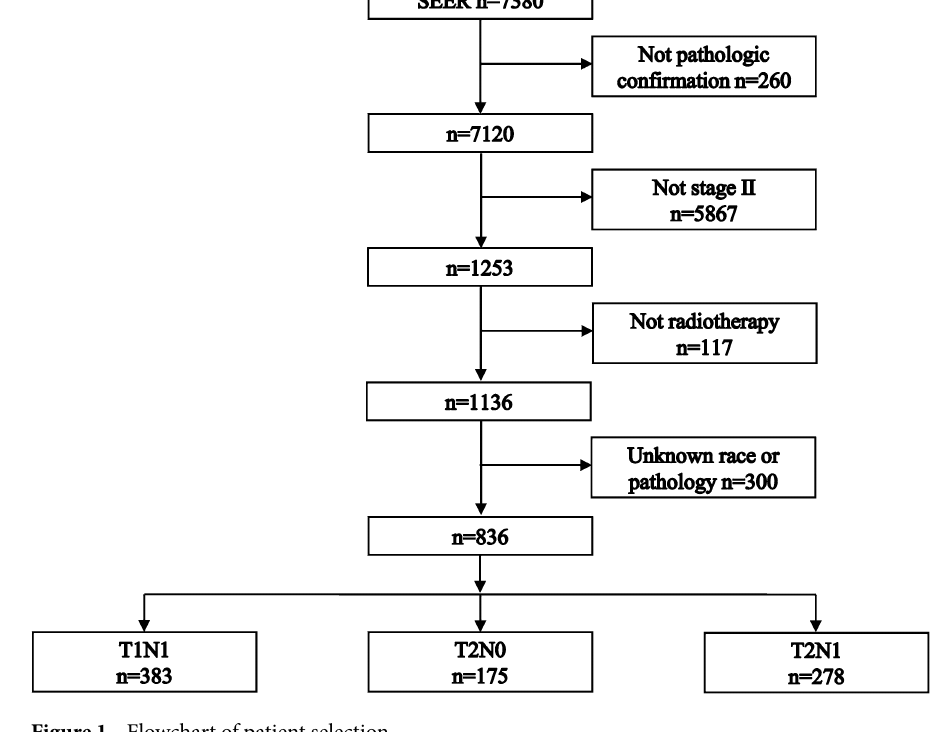
Figure 1. Flowchart of patient